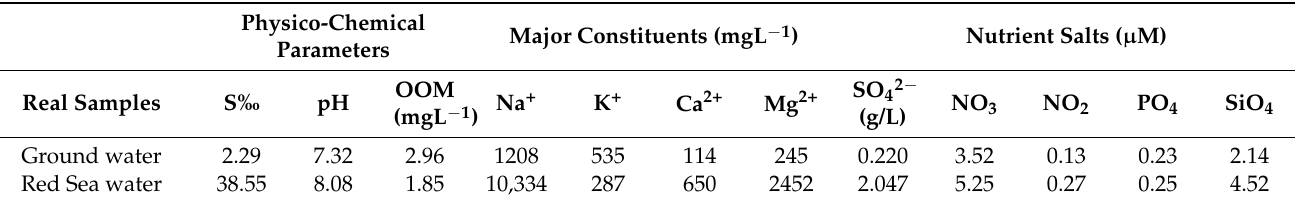
Table 7. Physico-chemical parameters, significant components, and nutrient salts.